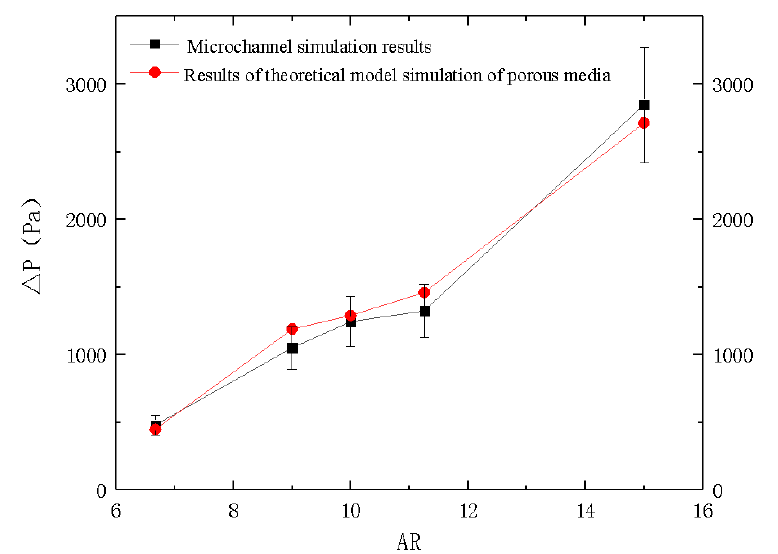
Figure 4. Curves of pressure drop on different ARs from microchannel and porous media simula-